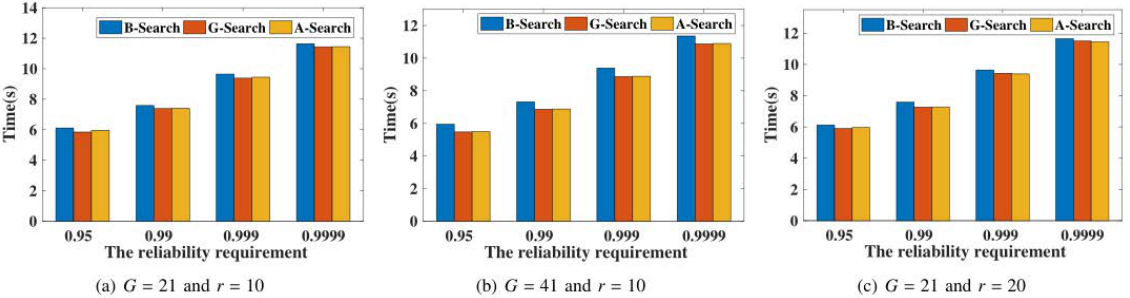
Figure 8. The time efficiency of each protocol under different reliability